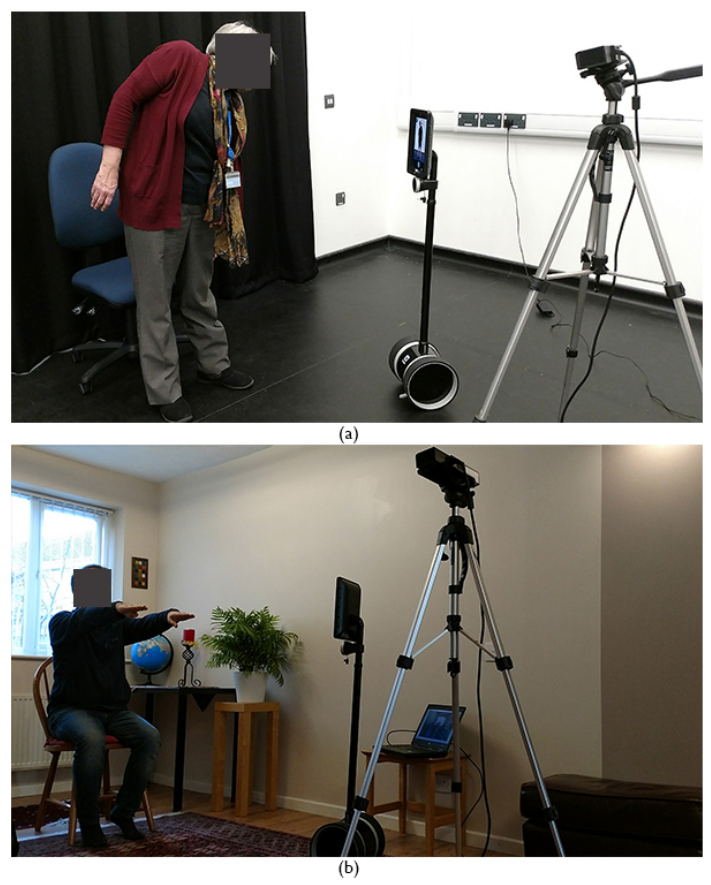
Figure 10. Participant evaluation: ( a ) Participant 1; and ( b ) Participant